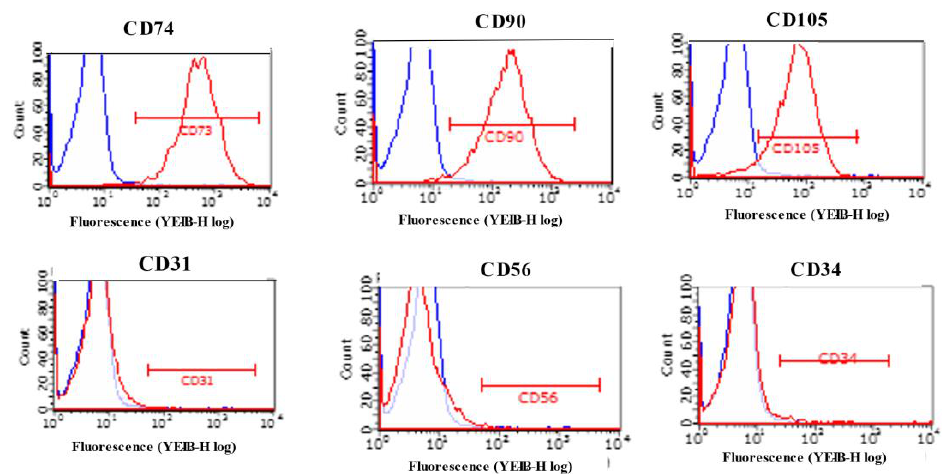
Figure 2. Flow cytometry analysis for isolated adipose-derived stem cells. Red curves PE-labeled against surface markers (CD74, CD90, CD105, CD31, CD56, CD34) antibodies. Blue curves, PE- labeled against IgG2a antibodies. Upper row, PE-labelled against CD74, CD90, and CD105 antibodies showing completely different curves from PE-labelled against IgG2a. Lower row, PE-labelled CD31, CD56, and CD34 antibodies showing curves nearly overlapping PE-labelled against